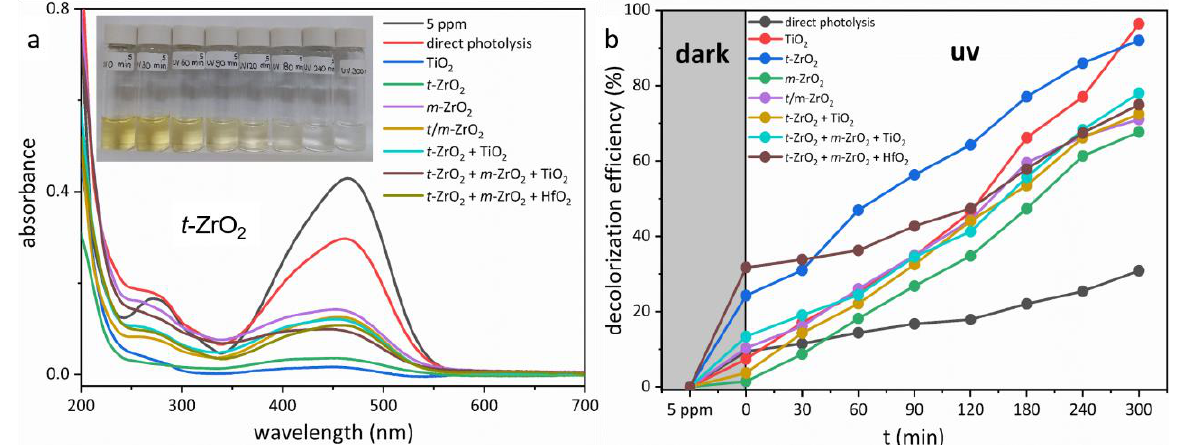
Figure 6. UV-vis spectra ( a ) and decoloration efficiency ( b ) of photocatalytic degradation MO with different catalysts.